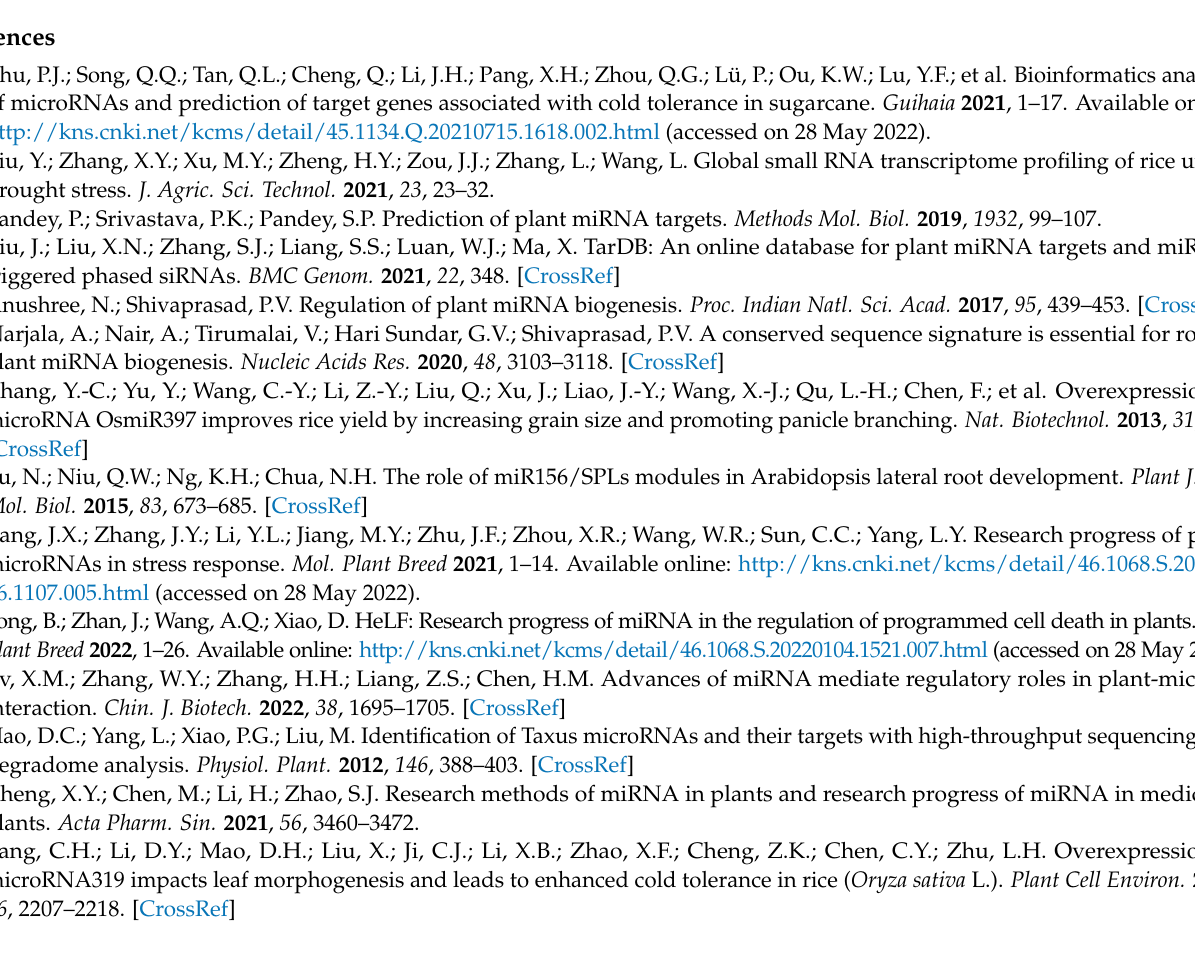
primer sequences of miRNA and target genes, Table S2: 421 differentially expressed miRNAs, Table S3: Predicted miRNAs identical potential target genes, Table S4: Expression trends (upregulated or downregulated) of antiinsect-related